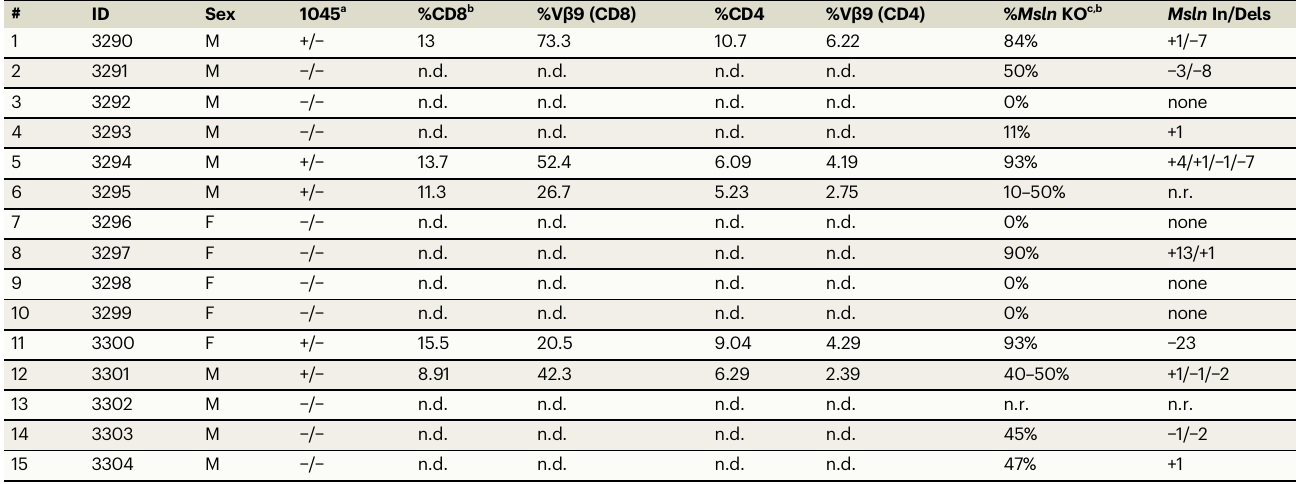
Table 1 | Analysis of T cells and Msln locus from 1045 TRex pups